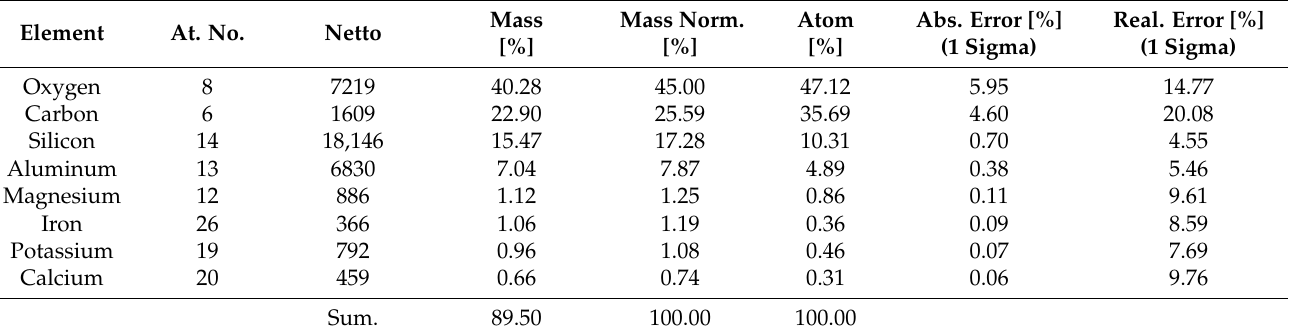
Table 3. Bentonite chemical composition.